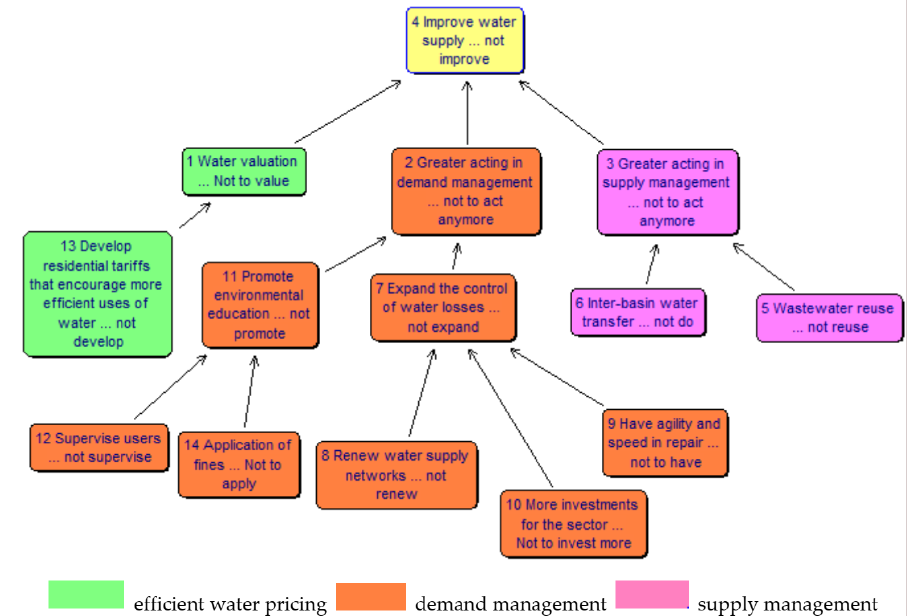
Figure 7. Congregated map of